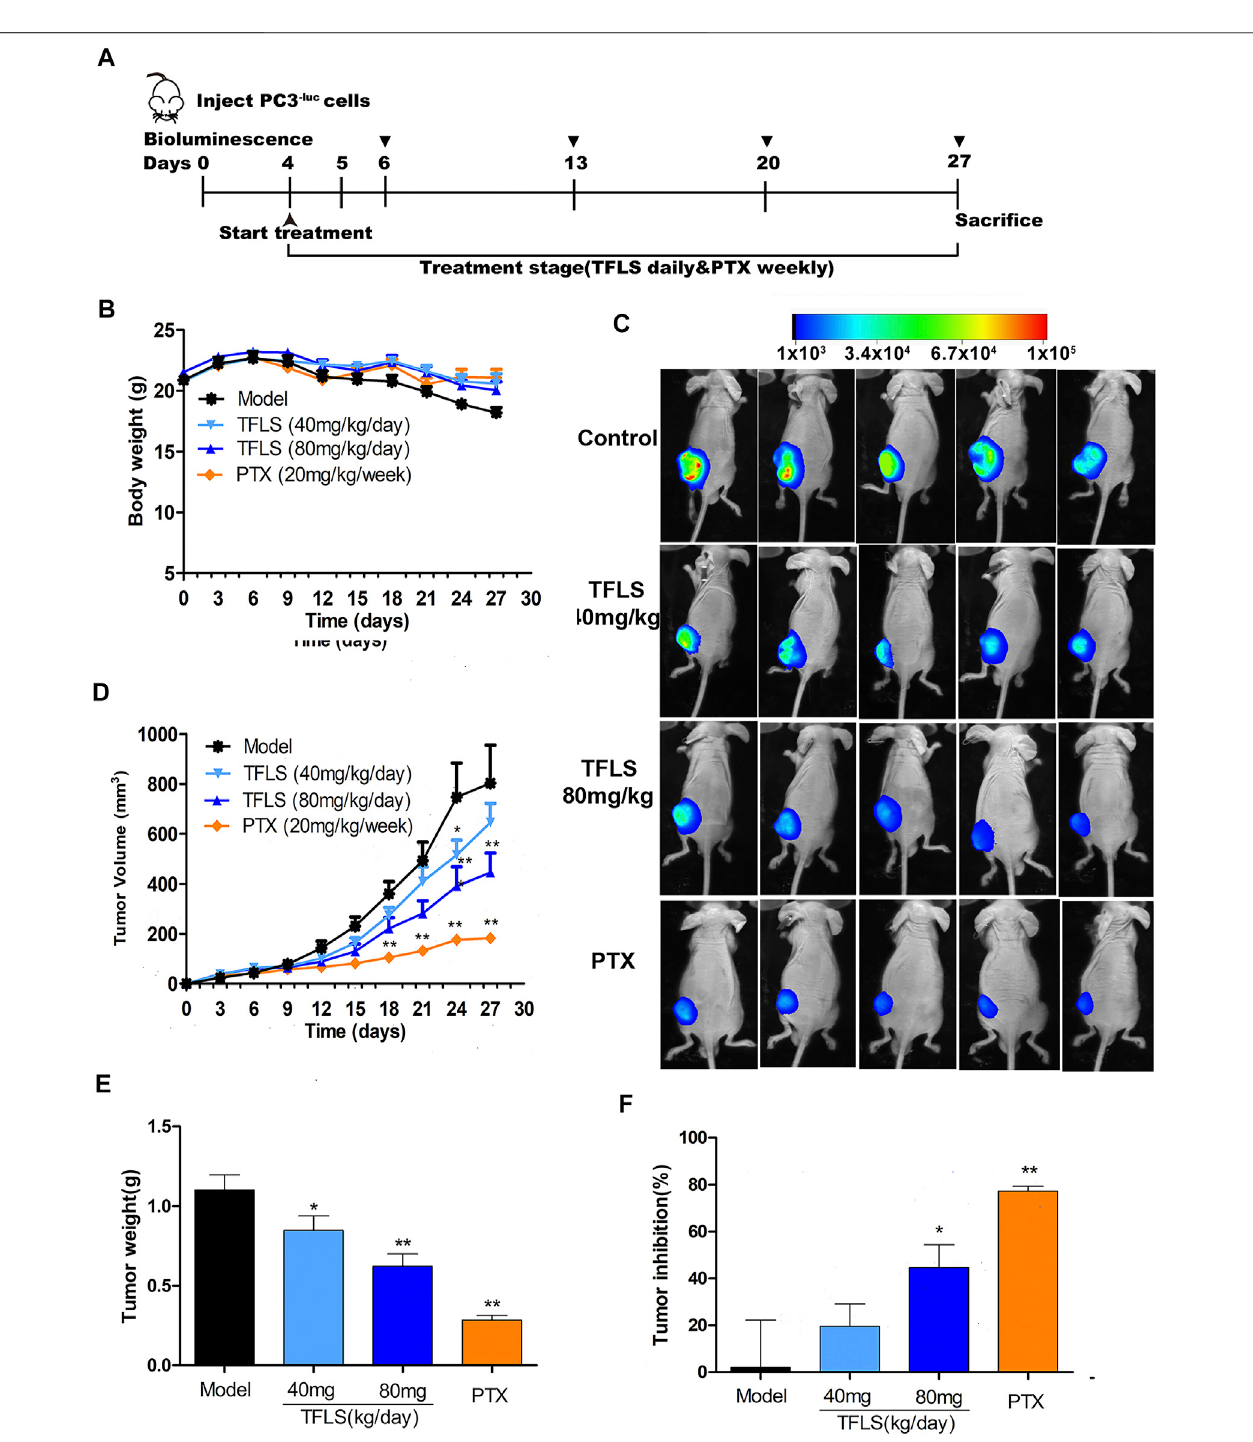
FIGURE 9 | TFLS suppressed tumor growth of PC3 − luc xenografts in vivo . (A) Outline of the animal experiment. (B) Body weight curves of mice in different groups during the whole treatment course. (C) Representative bioluminescence imaging of PC3 − luc xenograft tumors in different groups at the end of experiments. (D) Tumor growth curves ofmice in different groups during the wholetreatment course. (E) Tumor weight in differentgroups at the end of experiments. (F) Tumor inhibition ratesin different groups at the end of experiments. Data are presented as mean ± SEM. Compared to control group: * p < 0.05. ** p < 0.01. PTX: Paclitaxel.